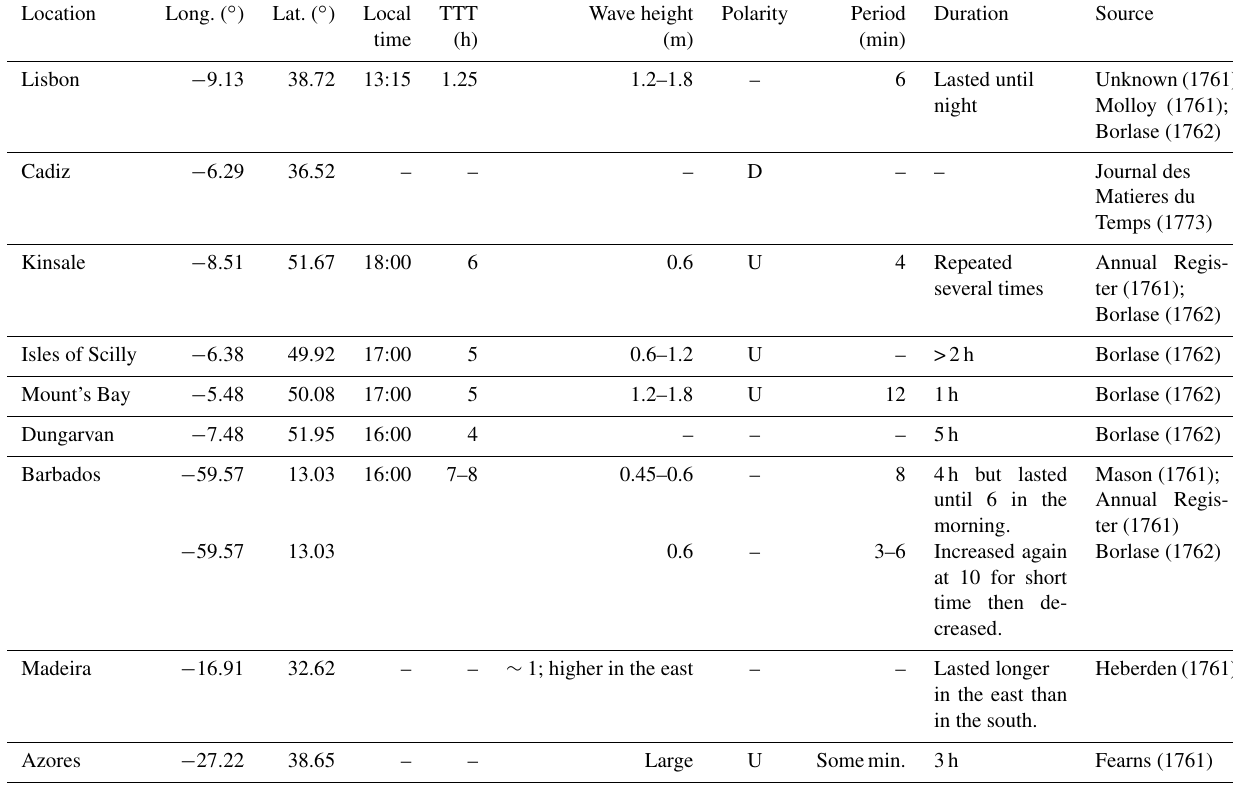
Table 1. Summary of the available data of the 1761 tsunami at the time. The column TTT lists the observed tsunami travel times. The column polarity indicates the first movement of the sea upward (U) or downward (D).